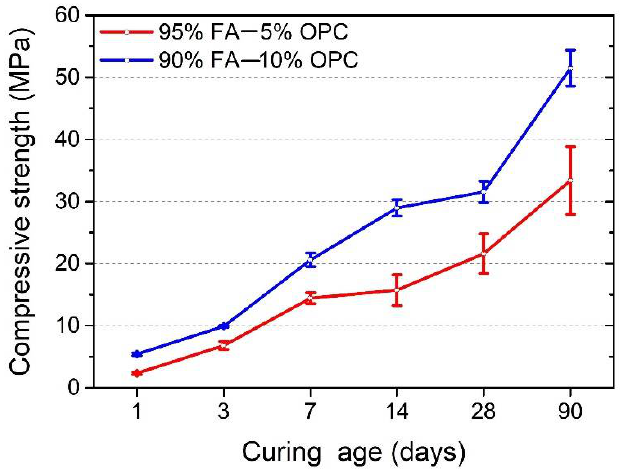
Figure 8. Evolution of compressive strength of optimal hybrid cement (Si/Al 5.5 and Na/Si 0.14): effect OPC content (5 and 10%).